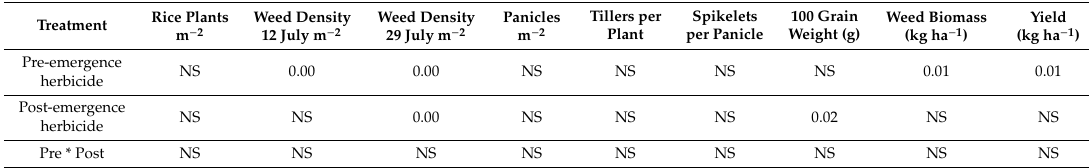
Table 7. Significant treatment e ff ects in 2019.